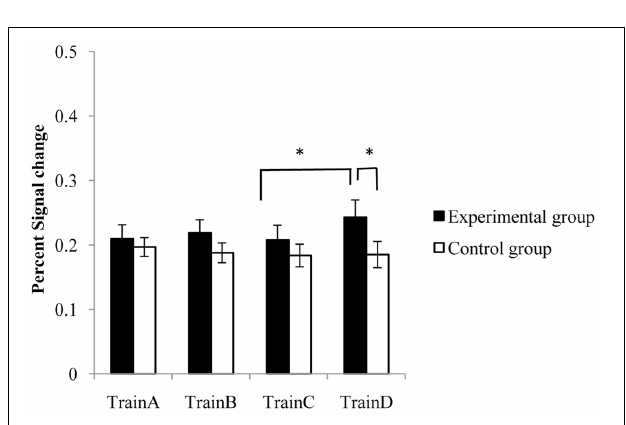
FIGURE 4 | The percent signal changes of the target ROI in the experimental group and the control group during rtfMRI training sessions. Error bar means the standard error. ∗ p < 0 .